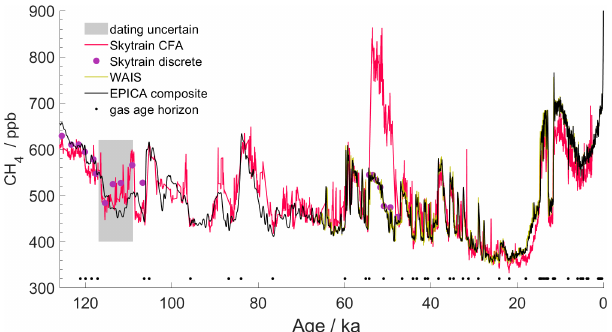
Figure 5. Methane from Skytrain Ice Rise on the ST22 age scale, along with reference data. Skytrain is shown by the red line (contin- uous) and purple dots (discrete data). In black is a spline of Antarc- tic data (Köhler et al., 2017). WAIS Divide is shown in yellow (Buizert et al., 2015; Mitchell et al., 2013). Ages shown here are AICC2012. Gas age tie points are shown along the bottom of the figure. The grey shaded area represents the ice (605–617m) with unreliable ages due to flow disturbance (see Sect.